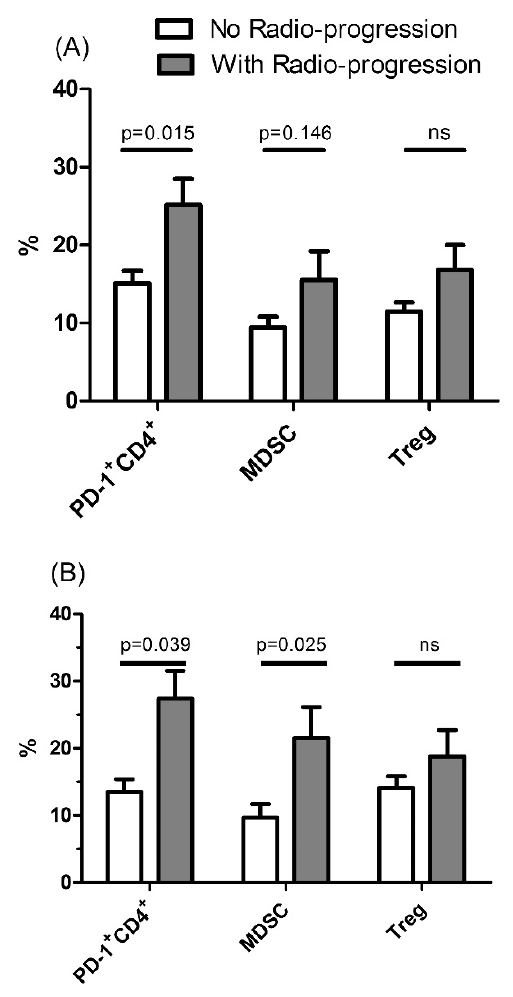
Figure 4. The percentages of programmed death-1 + (PD-1 + ) CD4 lymphocytes, myeloid derived suppressor cells (MDSCs), and regulatory T cells (Treg) between the patients with or without radiographic progression. ( A ) Initial data and ( B ) after 2 months of follow-up. Y axis means percentage in (1) lymphocyte population for Treg, PD-1 + CD4 + , and CTLA4 + CD4 + cells, and in (2) peripheral blood mononuclear cells for MDSCs. The data in the bar charts and error bars are mean and standard errors, respectively. The data were compared using the Mann Whitney U test. ns, not statistically significant ( p > 0.05)